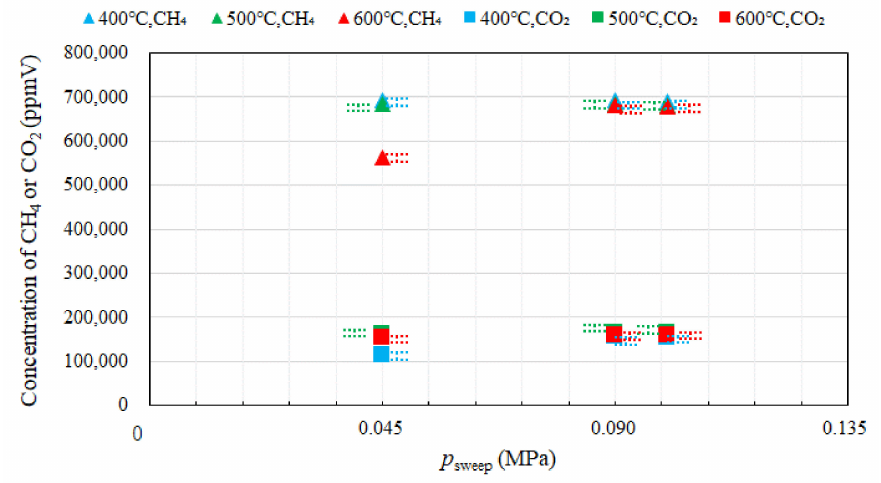
Figure 3. Impact of concentrations of CH 4 and CO 2 at the outlet of reaction chamber and p sweep with change in reaction temperature. (CH 4 :CO 2 =